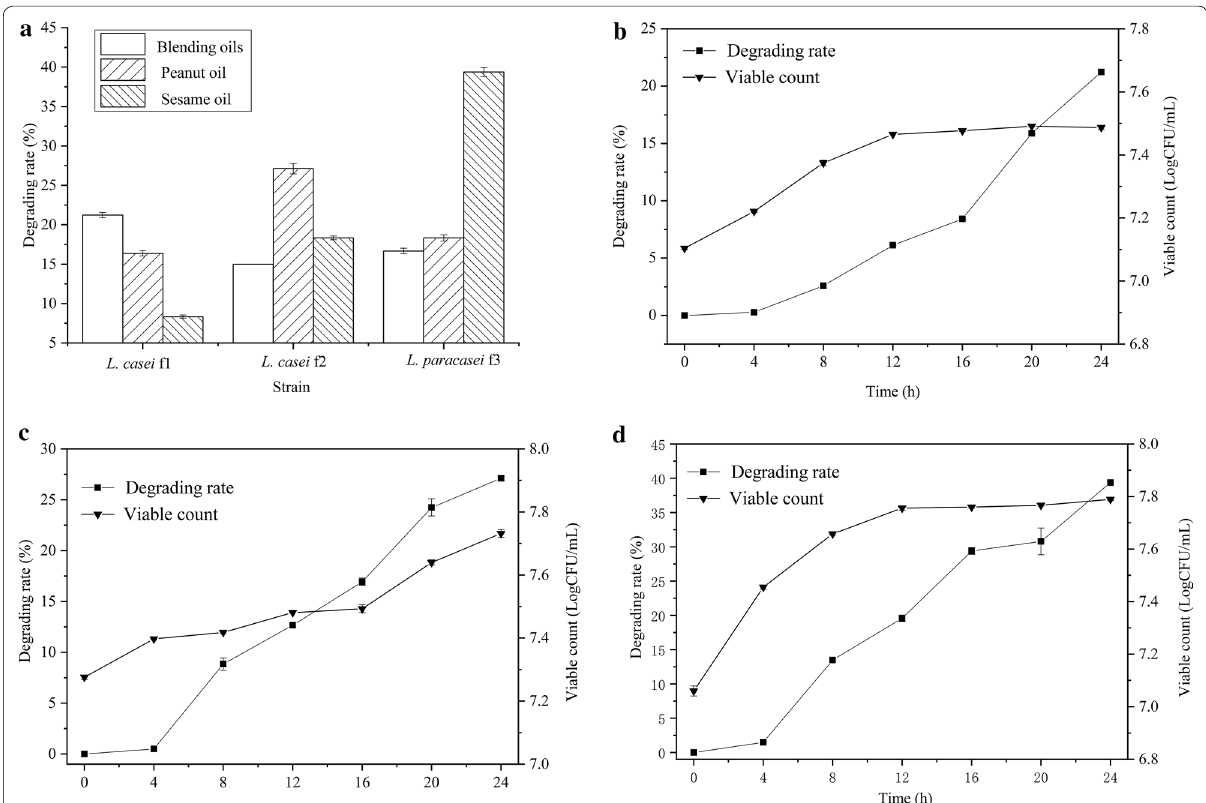
Fig. 4 The oil degrading activity of the isolated strains. L. casei f1, L. paracasei f2 and L. paracasei f3 were separately cultivated for 48 h in the mineral mediums containing blending oils, peanut oil and sesame oil as the sole carbon source, respectively. The weight of the corresponding degraded oils was measured ( a ). Moreover, sampling was implemented with an interval throughout the process when the strains cultivated in the mineral medium containing the preferred oils. The corresponding cell growth and the degraded oils of L. casei f1 to blending oils ( b ), L. paracasei f2 to peanut oil ( c ) and L. paracasei f3 to sesame oil ( d ) were analyzed. Data are presented as mean errors of